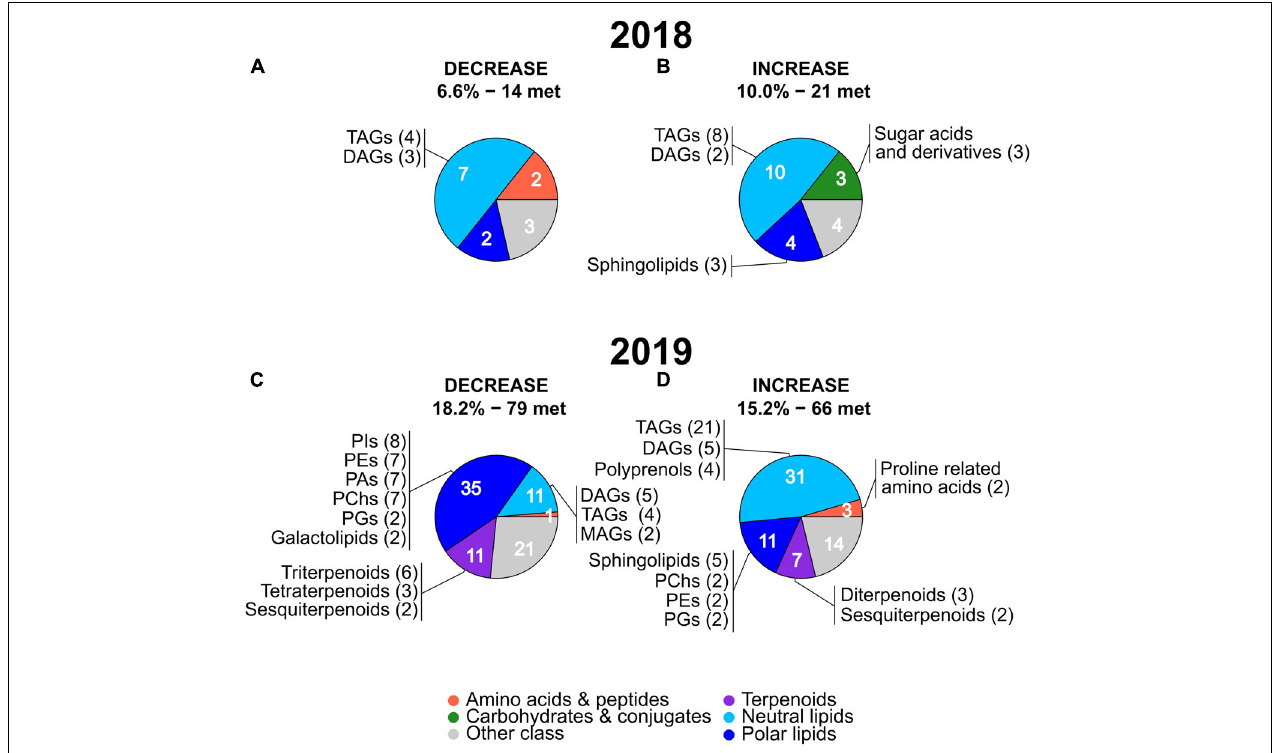
FIGURE 5 | Pie charts showing the main metabolic classes and subclasses of leaf metabolites with the strongest stress-induced mean FC decreases (A,C) or increases (B,D) in 2018 and 2019. The percentages and number of metabolites (“met.”) of each group (under decrease and increase) are the same as in the volcano plots in Figure 4 and the full lists of these metabolites are provided in Supplementary Tables 2, 3 . The number of metabolites present in the main metabolic classes are indicated in white. For each main metabolic class, subclasses including two or more metabolites (with the number of metabolites in brackets) are reported. The name and color of the main metabolic classes are indicated at the bottom of the figure. MAGs, monoacylglycerols; TAGs, triacylglycerols; DAGs, diacylglycerols; Pas, phosphatidic acids; PChs, phosphatidylcholines; PEs, phosphatidylethanolamines; PGs, phosphatidylglycerols; PIs,